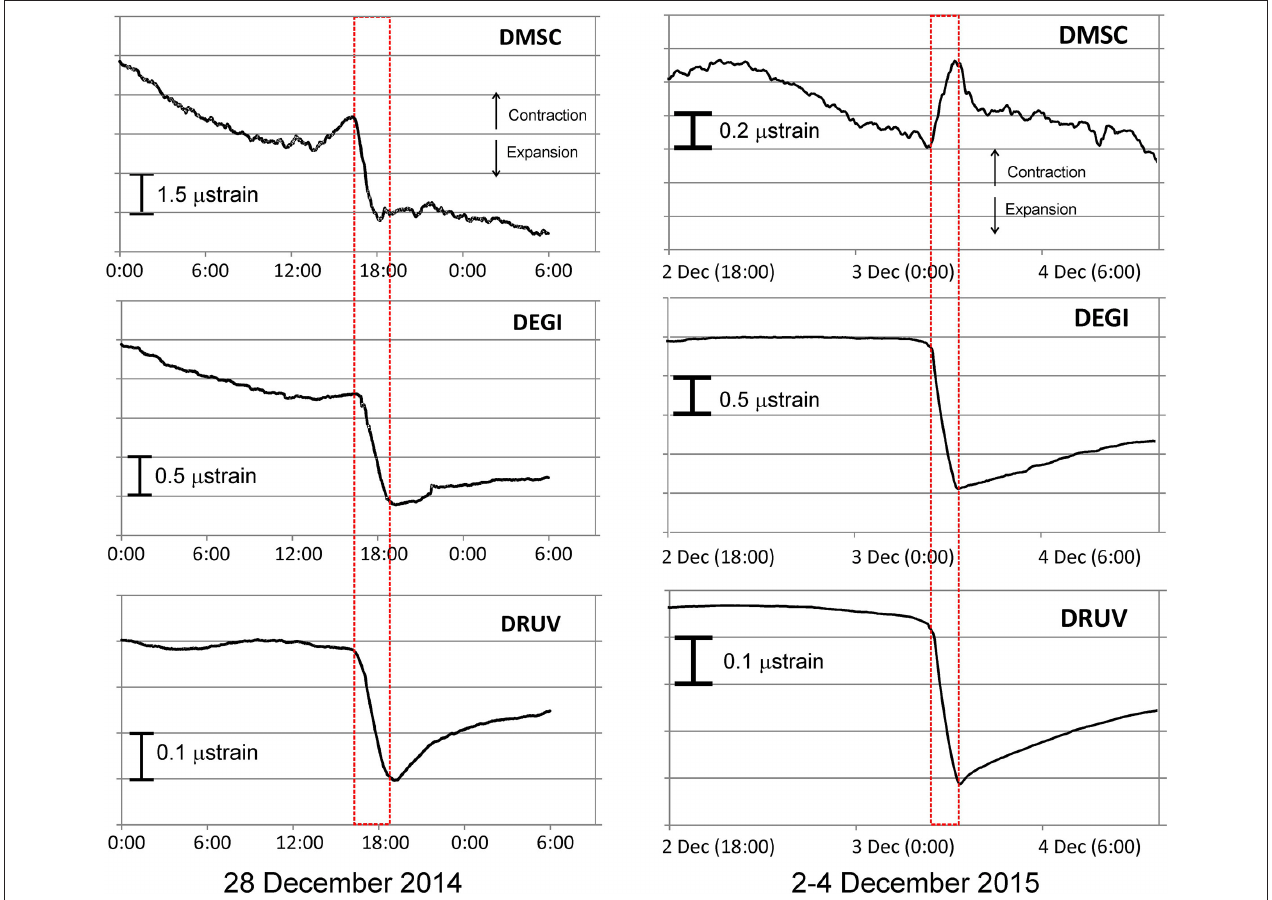
FIGURE 3 | Comparison between the volumetric strain changes recorded by the strain-meter during the 28 December2014 (left) and the 3 December 2015 lava fountains. A clear reverse in sign at the near summit station DMSC is detected, implying a deeper source position for the 2015 case (right) .